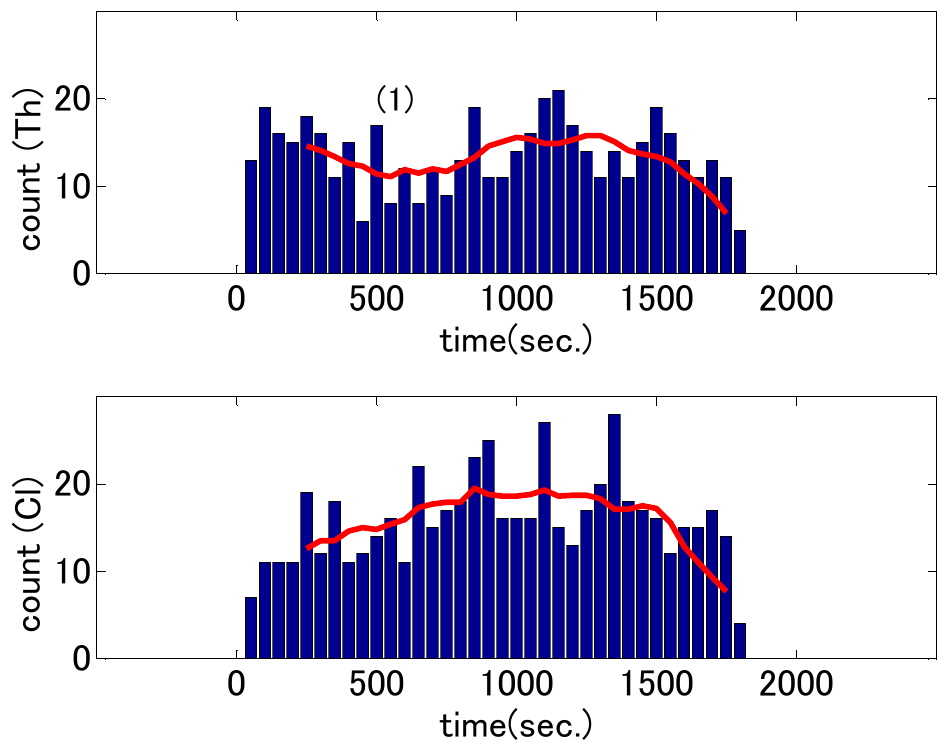
Figure 4. Nodding counts for the therapist (Th) and client (Cl) during the second dialogue. The bars represent the counts and the line corresponds to the eleven-point average values. The number in parentheses correspond to the numbers in Table